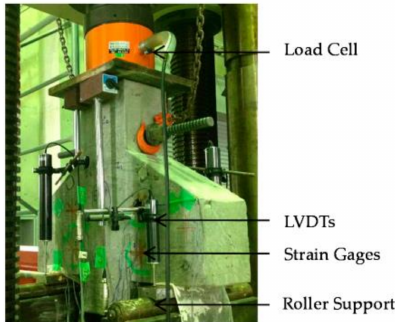
Figure 5. Test setup and